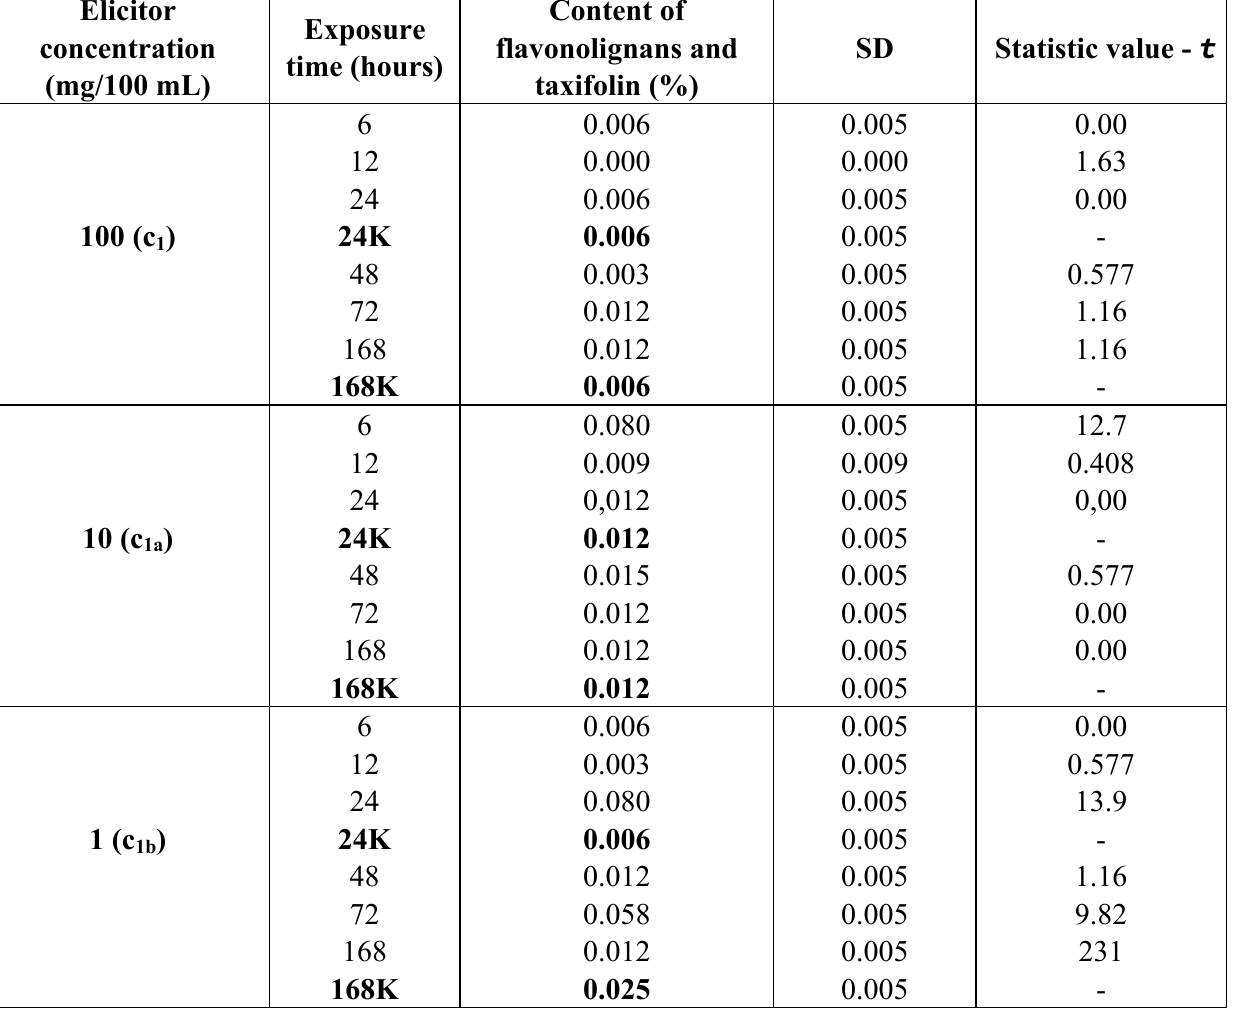
Table 1. Flavonolignans and taxifolin content (%) in callus culture S. marianum after elicitation with compound 1